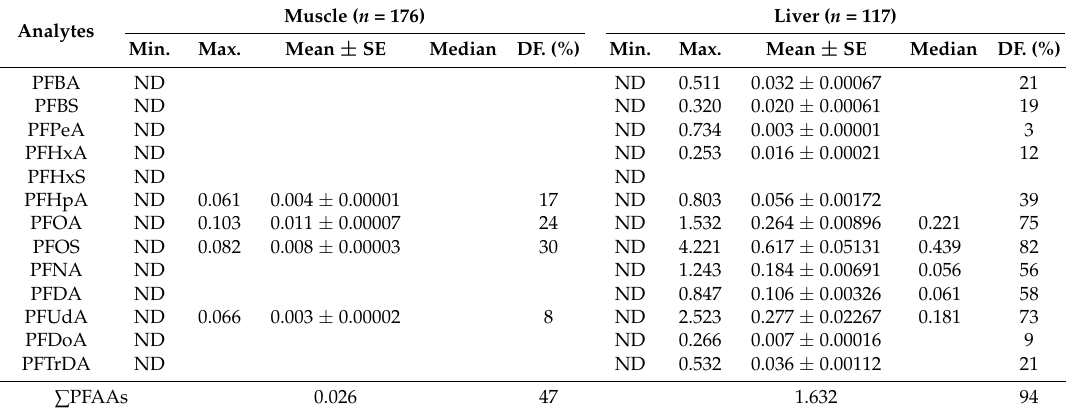
Table 1. The concentrations of perfluoroalkyl acids (PFAAs, ng/g, wet weight) in beef muscle and beef liver from